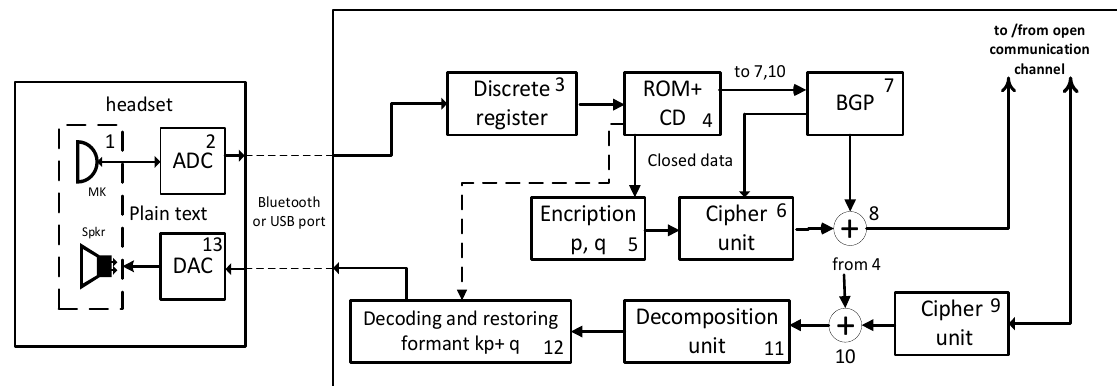
Figure 1. Block diagram of the encryption and decryption